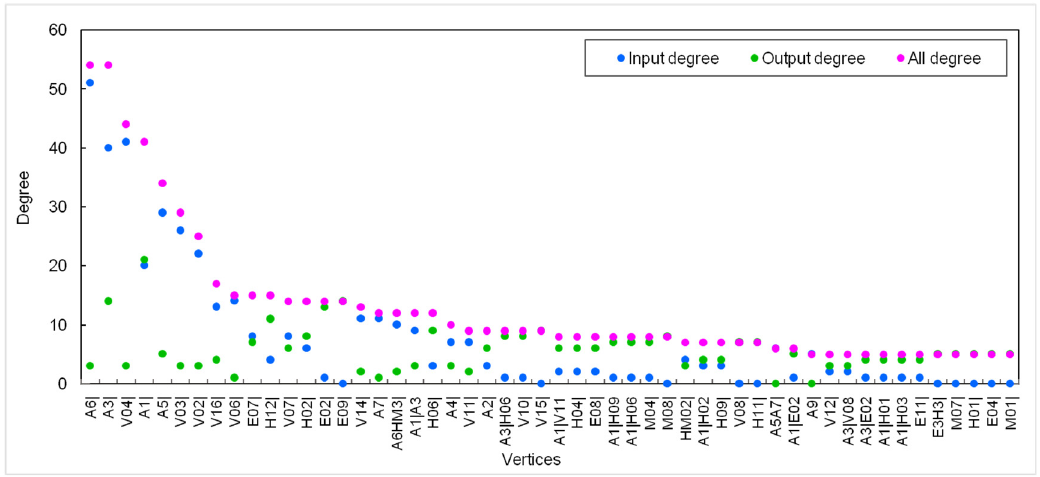
Figure 5. The nodes whose values of all 0 degree are more than 5.